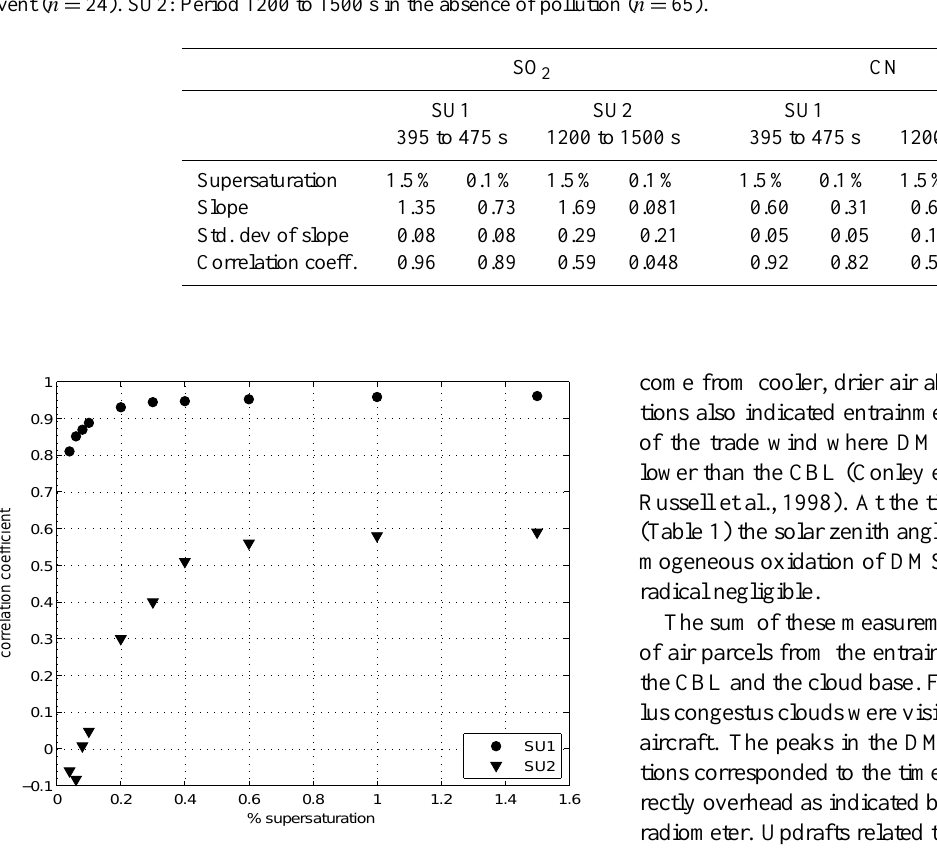
Fig. 7. Correlation coefficients for linear regressions of CCN num- ber concentrations at various supersaturations on SO 2 concentra- tions. SU1: a pollution plume from 400 s to 500 s of circle at 90m. SU2: for the period 1200 s to 1500 s of the circle at 90m in the absence of